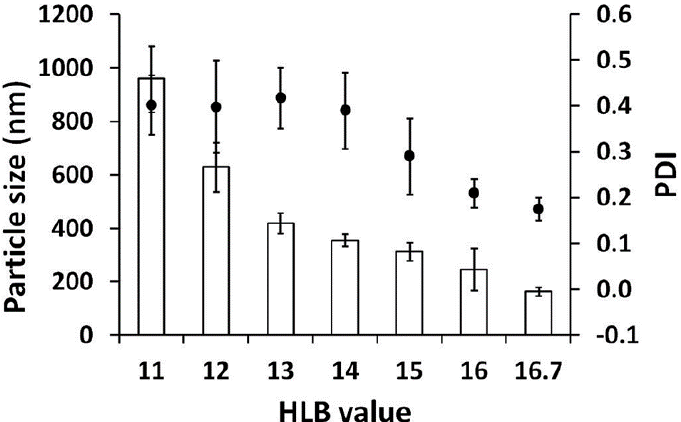
Figure 3. Internal droplet size ( ) and PDI ( • ) of AGO/surfactant/co-surfactant/water system. Effect of HLB values of surfactants was studied with PG as a co-surfactant.